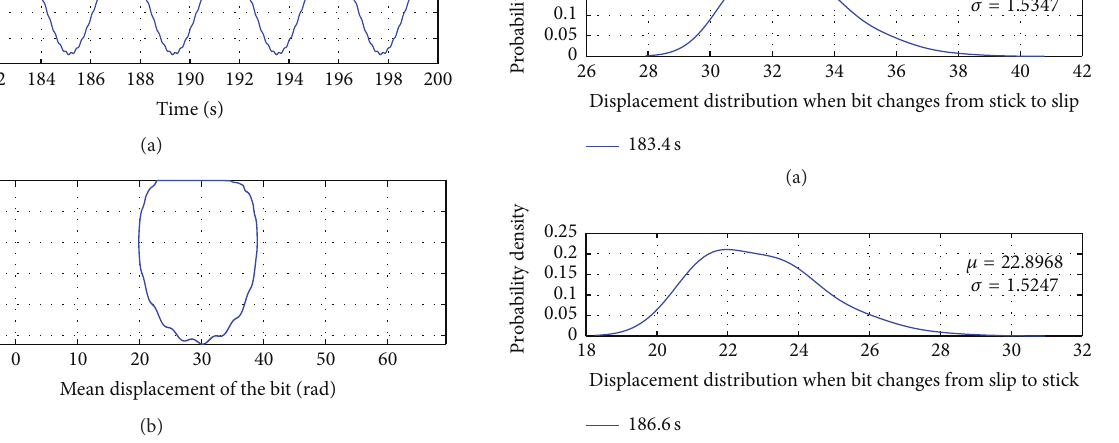
Figure 6: Mean response with stick-slip: (a) time history; (b) phase plane.